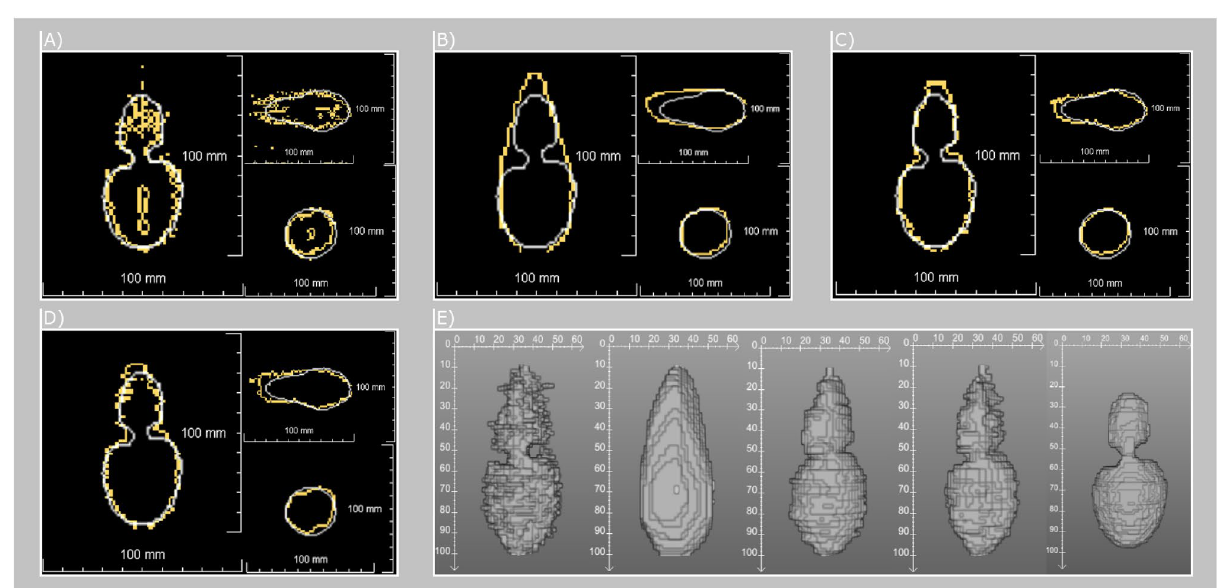
Figure 3. Reconstructions for perfusion phantom 2. Visible are the ground truth contours (white) in addition to the output contour (yellow) in axial, sagittal an coronal. ( A ) Temperature Interpolation. ( B ) Delaunay triangulation. ( C ) MVEE. ( D ) Splines. ( E ) 3D representation without smoothing for all methods including the ground truth at the